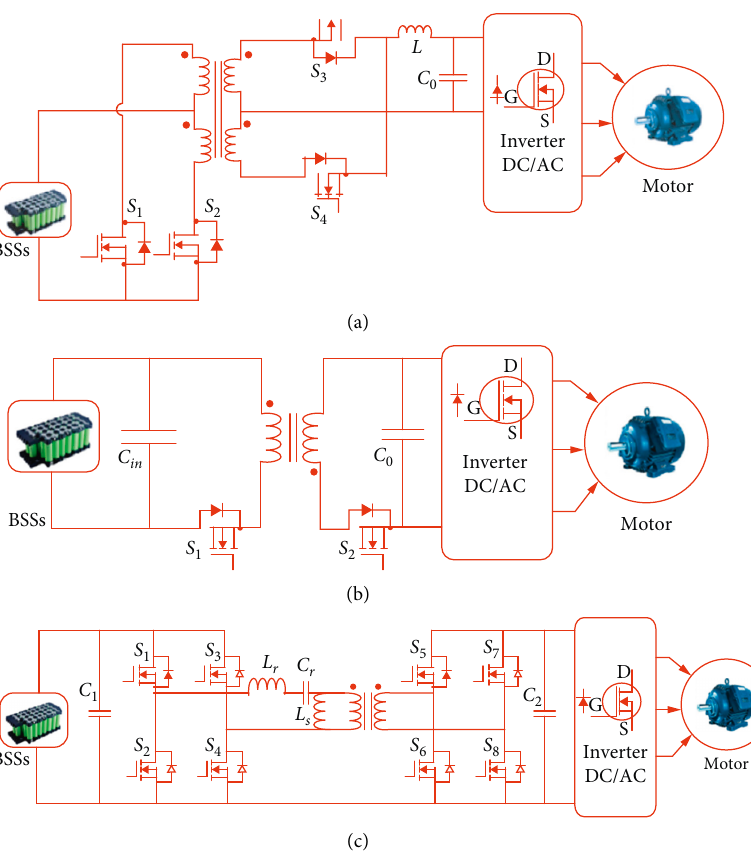
Figure 15: Topologies of transformerized DC-DC converter for EVs: (a) push-pull converter, (b) flyback converter, and (c) resonant